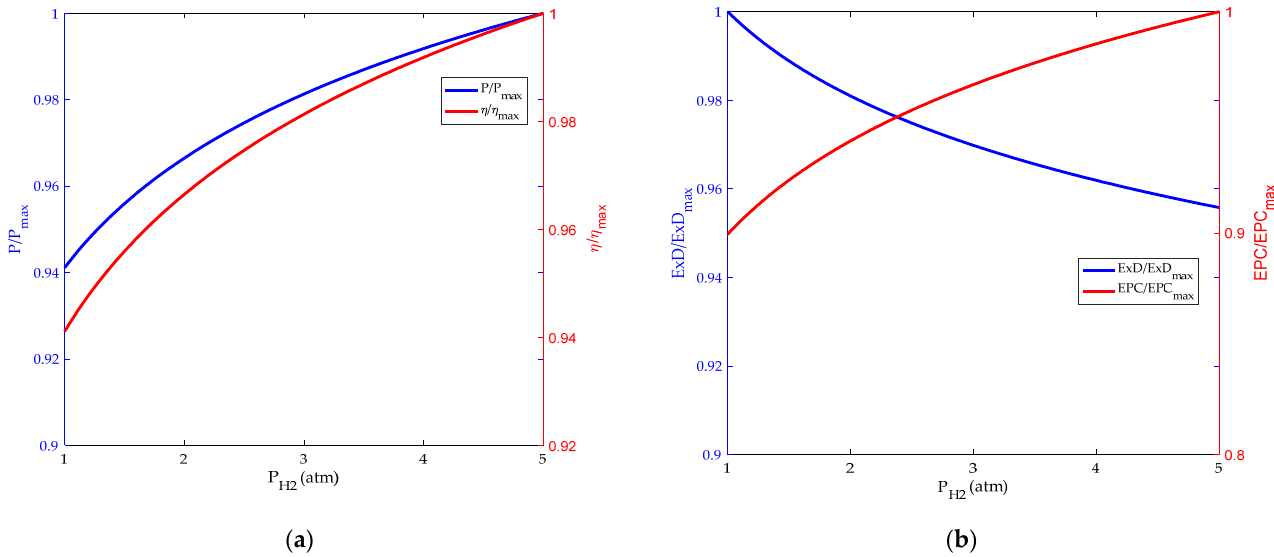
Figure 7. Influence of hydrogen pressure. ( a ) Power density and energy efficiency; ( b ) exergy destruction rate and exergetic performance coefficient.